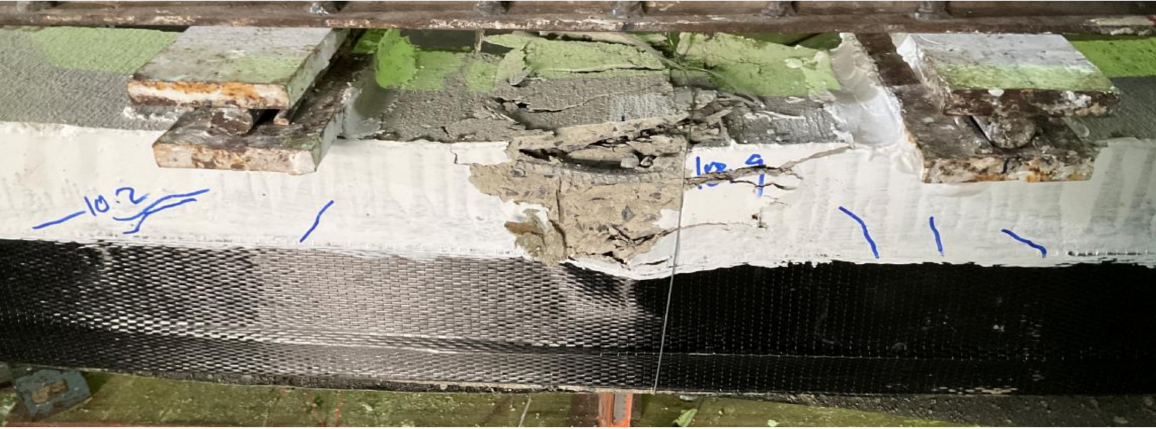
Figure 20. Pronounced concrete crushing observed in beams B06 and